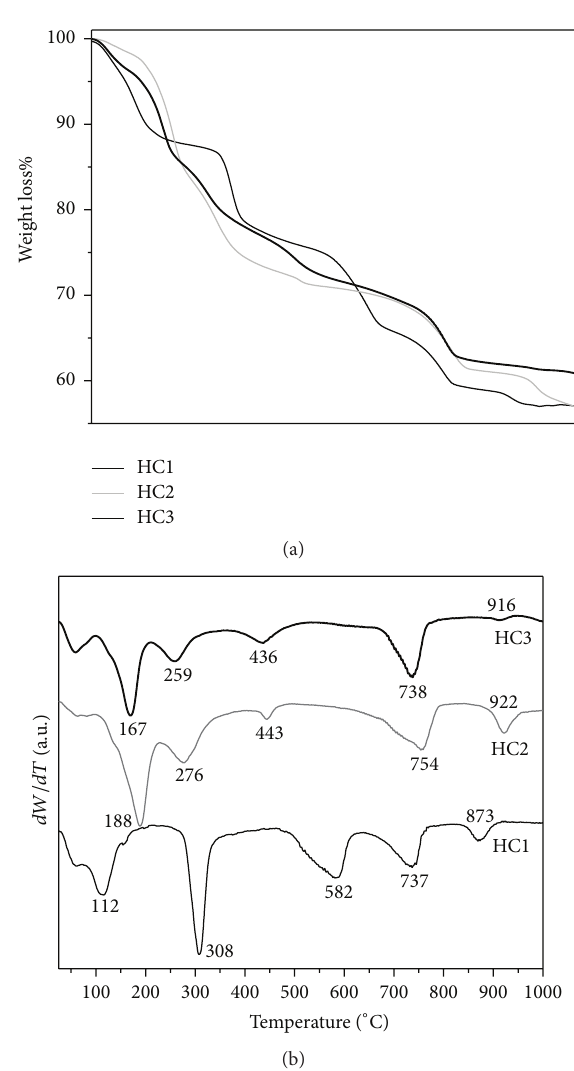
Figure 4: Thermogravimetric analysis results: (a) TG and (b) 1st derivative